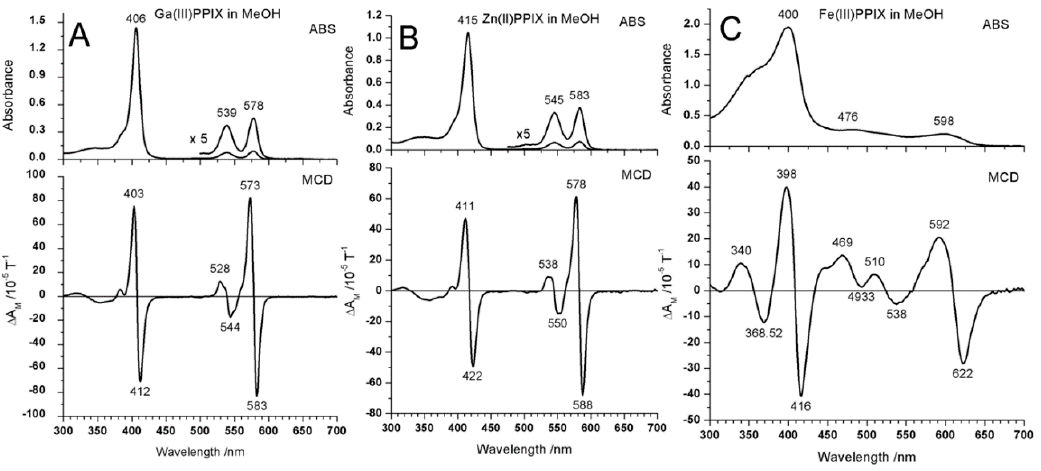
Figure 7. Absorption and magnetic circular dichroism (MCD) spectra of ( A ) Ga(III)-PPIX, ( B ) Zn(II)-PPIX and ( C ) Fe(III)-PPIX all in methanol. Reproduced with permission of the